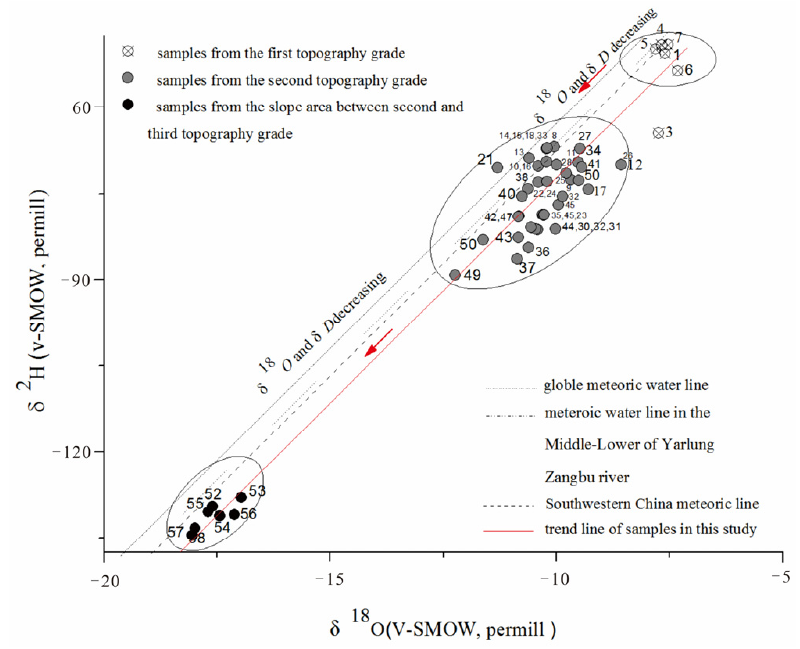
Figure 8. Relationship between δ 18 O (V − SMOW, permill) and δ 2 H (V − SMOW, permill).